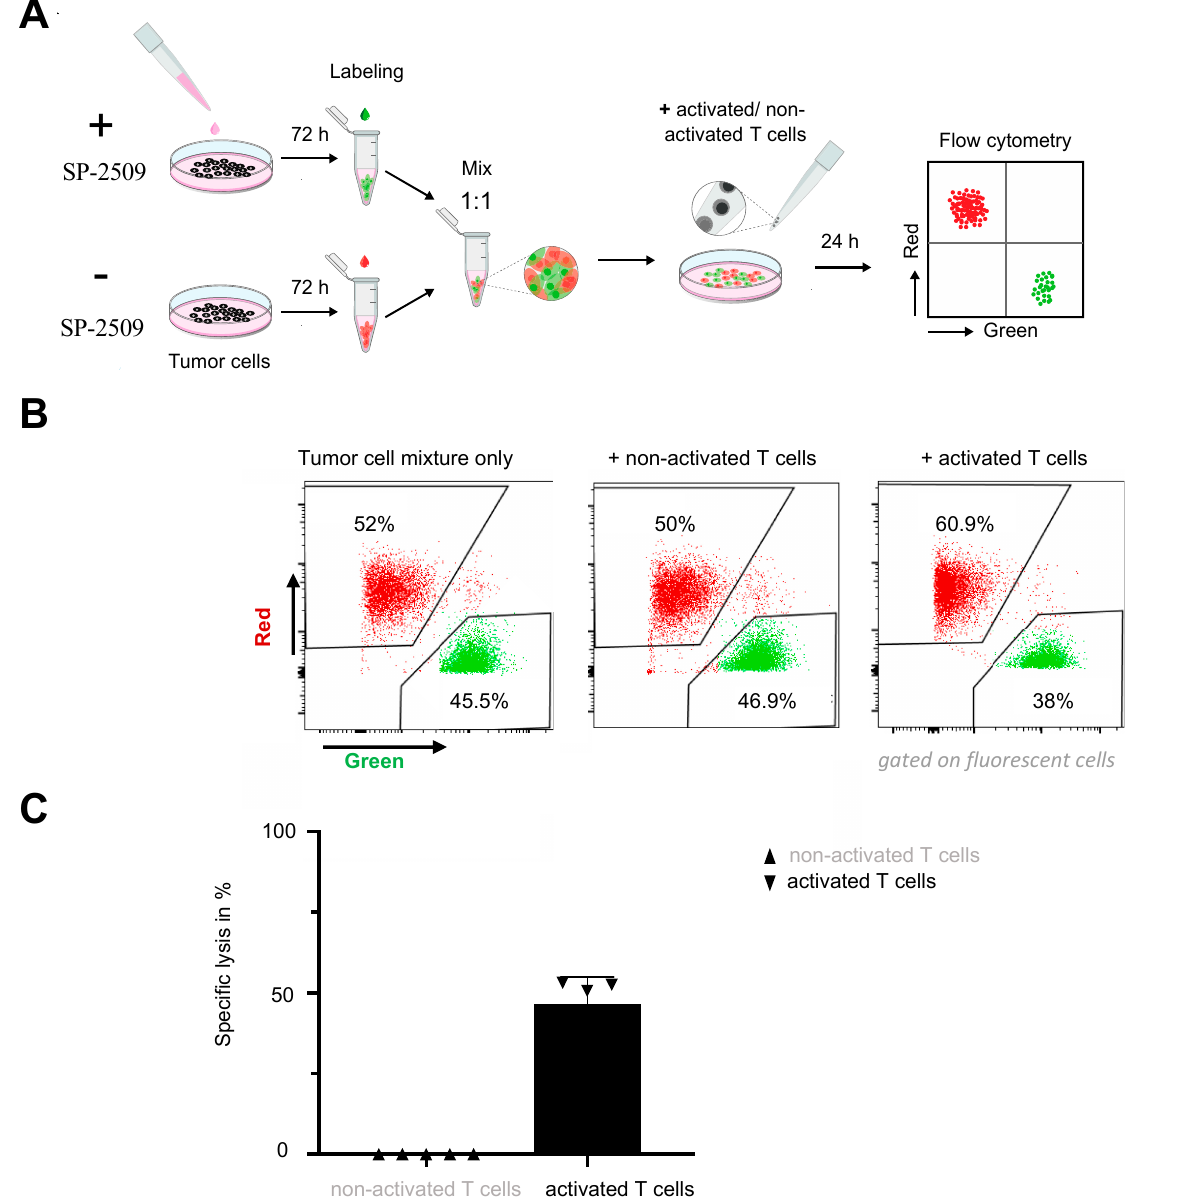
Figure 4. Combination therapy was beneficial for eradicating tumor cells lacking the tumor antigen. ( A ) Experimental timeline for the combination therapy. ( B ) Killing efficacy of activated or unactivated untransduced T cells after 24 h coculture with SH-SY5Y-L1CAM-ko cells treated with 0.5 µM SP-2509 (or untreated controls) at an effector:target ratio of 1:1. ( C ) Specific lysis of SP-2509 pretreated SH-SY5Y-L1CAM-ko cells by unactivated or activated T cells (mean ± SD, n = 4).